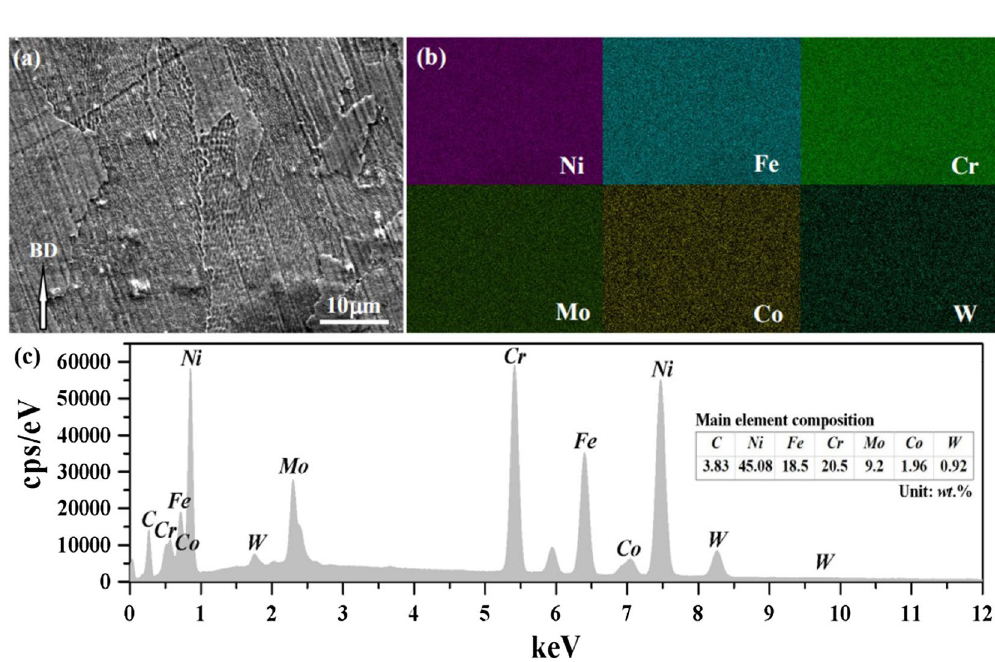
Figure 13. FE-SEM image ( a ) from the cross-section view parallel to BD of the LPBF-built Hastelloy X and its corresponding regional EDS results of Ni, Fe, Cr, Mo, Co, W elemental maps ( b ) and their energy spectrum ( c